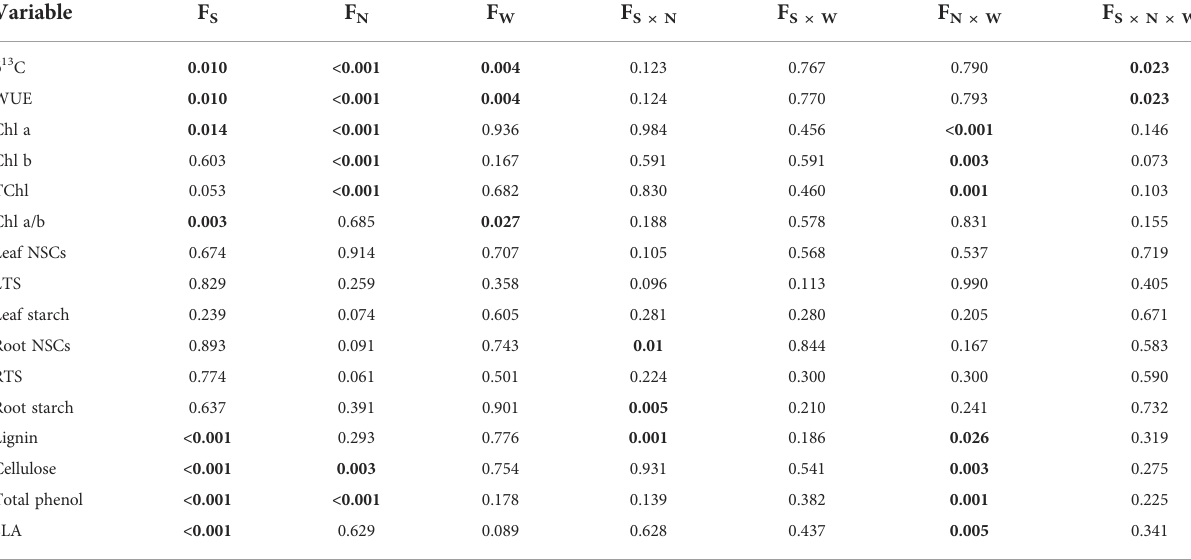
TABLE 2 Effects of species, nitrogen, water, and their interactions on non-structural carbohydrates, water use ef fi ciency, and other physiological properties using three-way ANOVA.